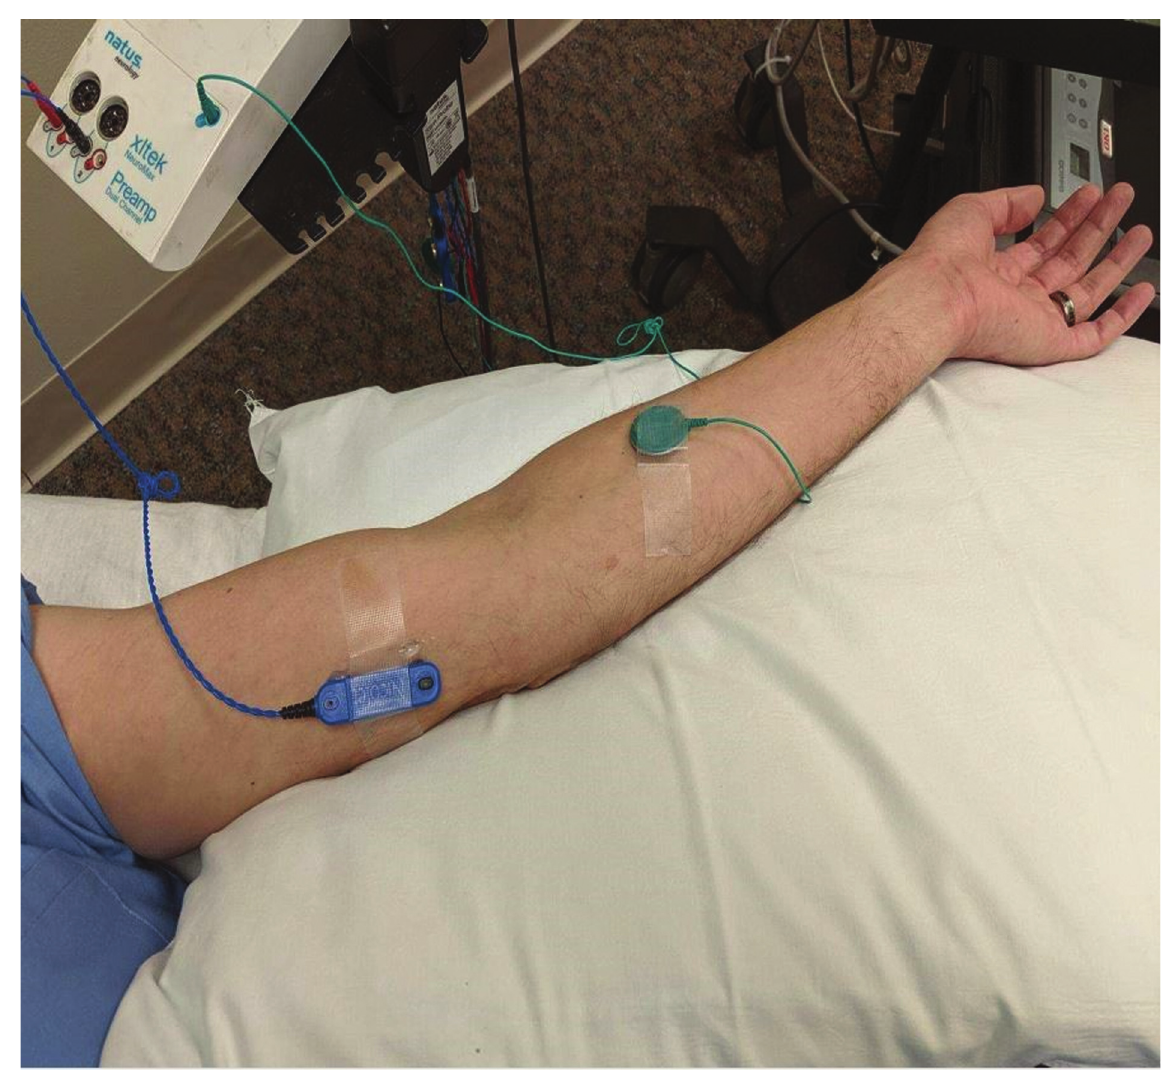
Fig. 1 Electrode placement for mixed across the